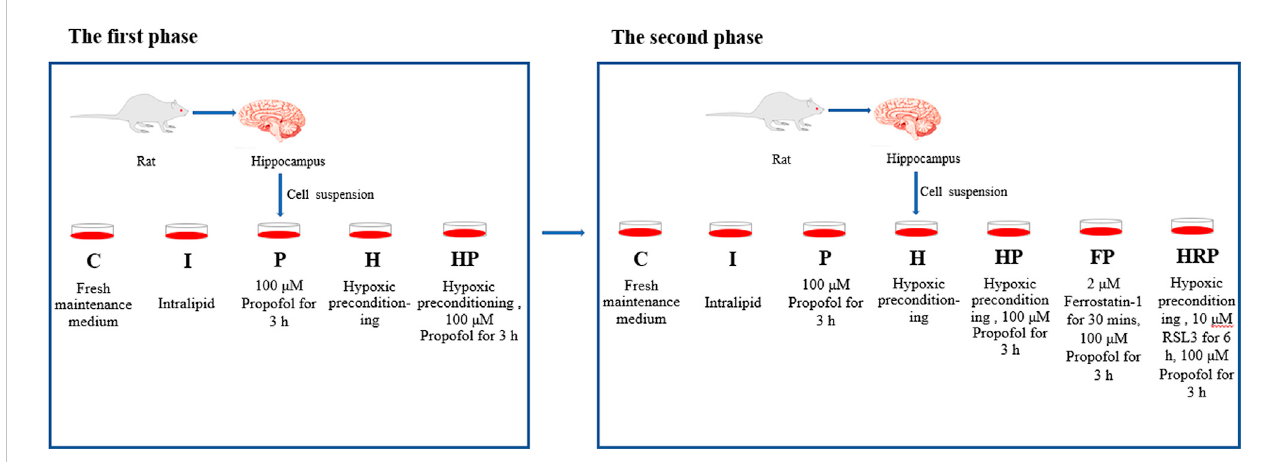
FIGURE 1 Experimentalgroupsand treatments. Inthe fi rst phaseoftheresearch, thecells inGroupCandGroup Iwereincubated withfresh maintenancemedium and intralipid vehicle, respectively. The cells in Group P were incubated with 100 μ M propofol for 3 h. Cells in Group H were treated with hypoxic preconditioning, and cells in Group HP were subjected to hypoxic preconditioning before incubation with propofol. In the second phase of the research, the cells in Group C, Group I, Group P, Group H and Group HP were processed as the fi rst phase of the study. The cells in Group FP were treated with 2 μ M ferrostatin-1 for 30 min before incubation with propofol. The cells in the HRP group were treated with 10 μ M RSL3 for 6 h after hypoxic preconditioning and then incubated with 100 μ M propofol for 3